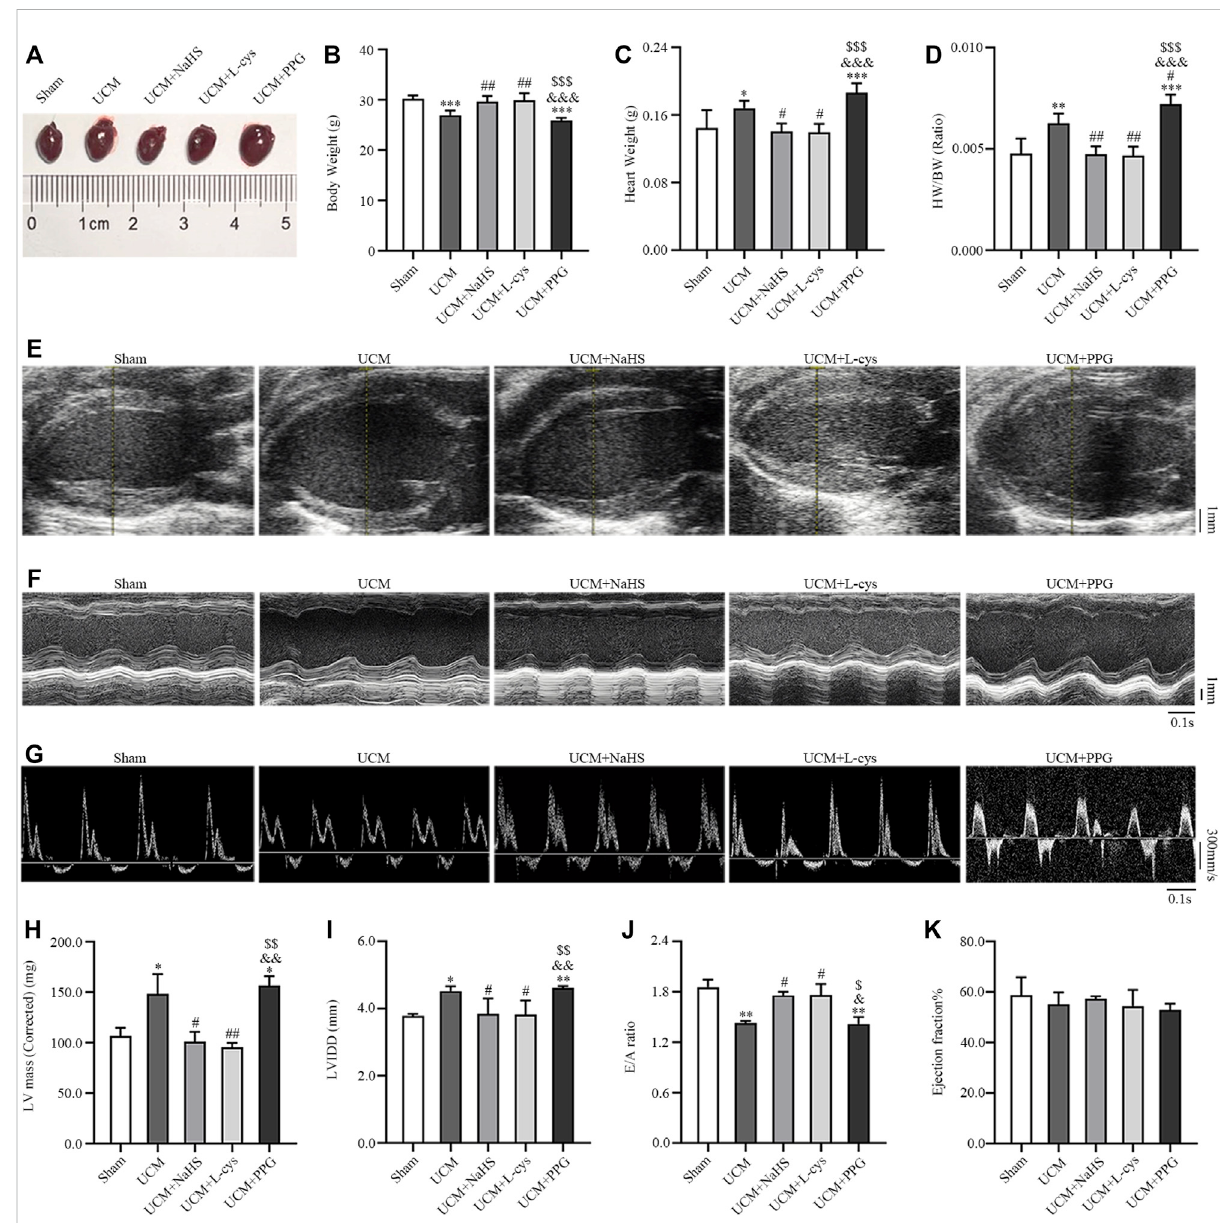
FIGURE 3 NaHS and L-cys treatment improved left ventricular hypertrophy (LVH) and diastolic dysfunction in UCM mice. (A) Representative images of heart tissues in the fi ve groups of mice. (B – D) H 2 S treatment reduces heart weight and heart weight/body weight. n = 6 per group. (E – G) Representative echocardiographic images in the fi ve groups of mice. (E) Two-dimensional echocardiograms showing left ventricular long-axis views, with scale bar in mm on right. (F) M-mode echocardiograms showing left ventricular dimensions, with scale bar in mm on right and time stamp in seconds at the bottom. (G) Pulse-wave Doppler echocardiograms depicting mitral in fl ow velocities, with scale bar in mm on right and time stampinsecondsatbottom. (H – K) H 2 StreatmentimprovesLVH anddiastolicdysfunctioninUCMmice. n =3pergroup. E/A:theratiooftheearlyto late diastolic mitral in fl ow velocities; LVIDd: LV internal diameters at end-diastole; HW/BW: heart weight/body weight. Data are represented as Mean ± SEM. * p < 0.05, ** p < 0.01, *** p < 0.001 vs Sham group; # p < 0.05, ## p < 0.01 vs. UCM group; & p < 0.05, && p < 0.01, &&& p < 0.001 vs. UCM + NaHS group; $ p < 0.05, $$ p < 0.01, $$$ p < 0.001 vs. UCM + L-cys